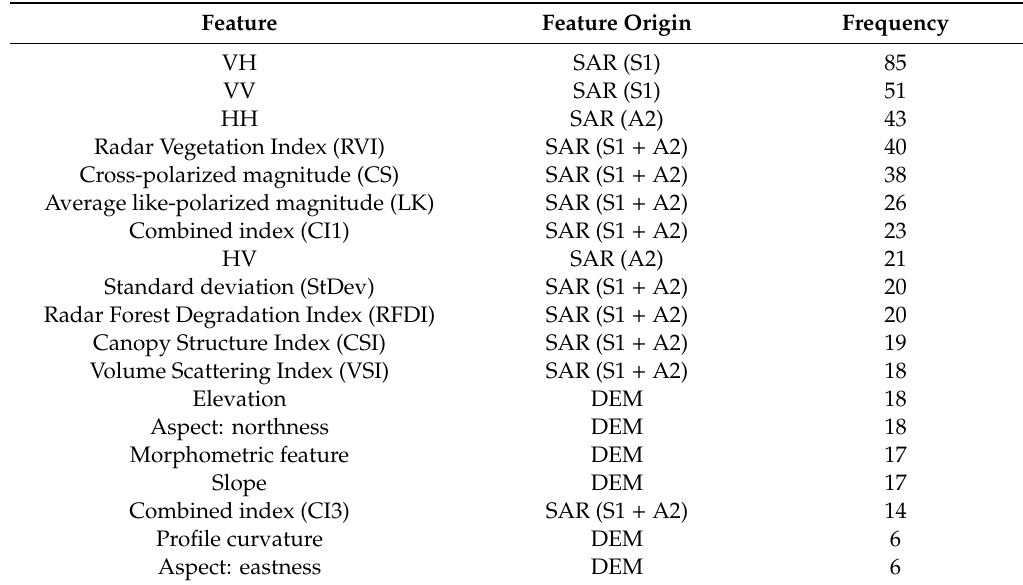
Table 4. Frequency of the 500 most important features used for the classification. DEM = digital elevation